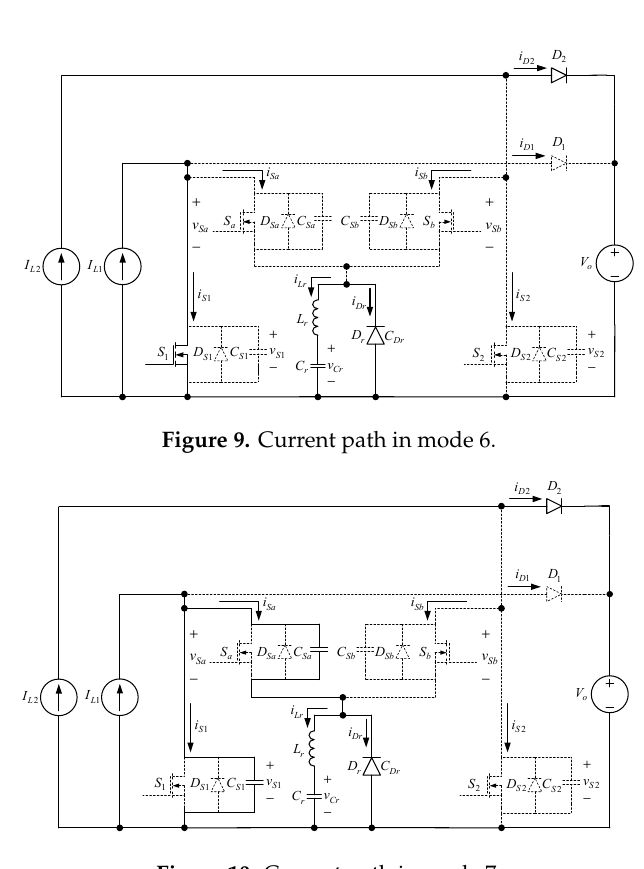
Figure 10. Current path in mode 7.